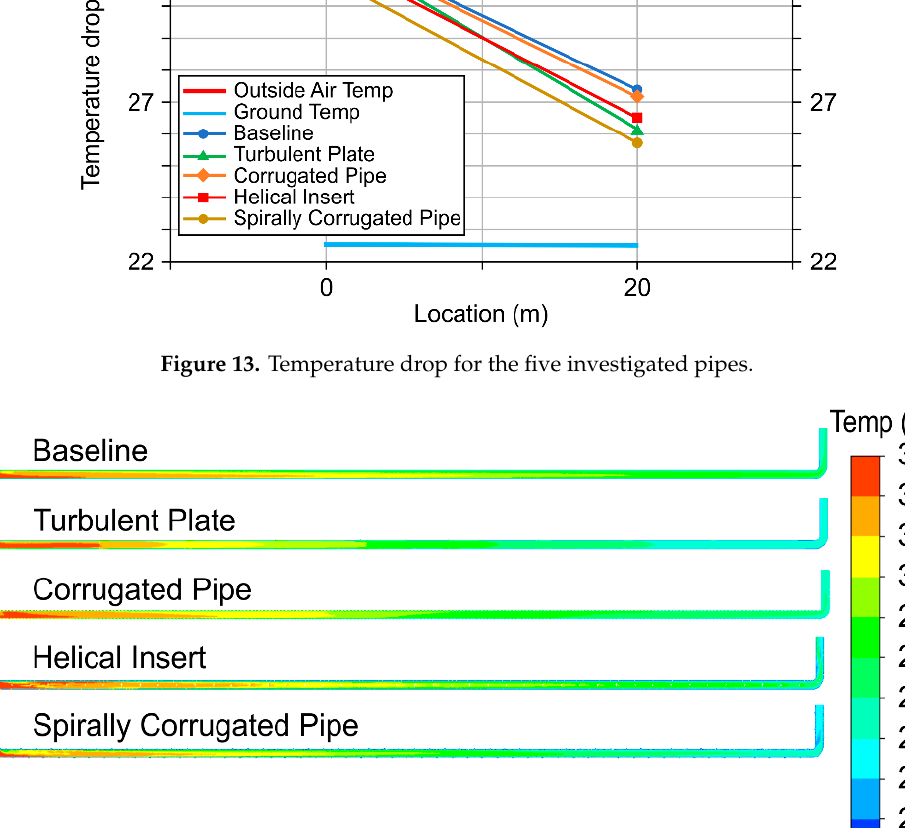
Figure 13. Temperature drop for the five investigated pipes.